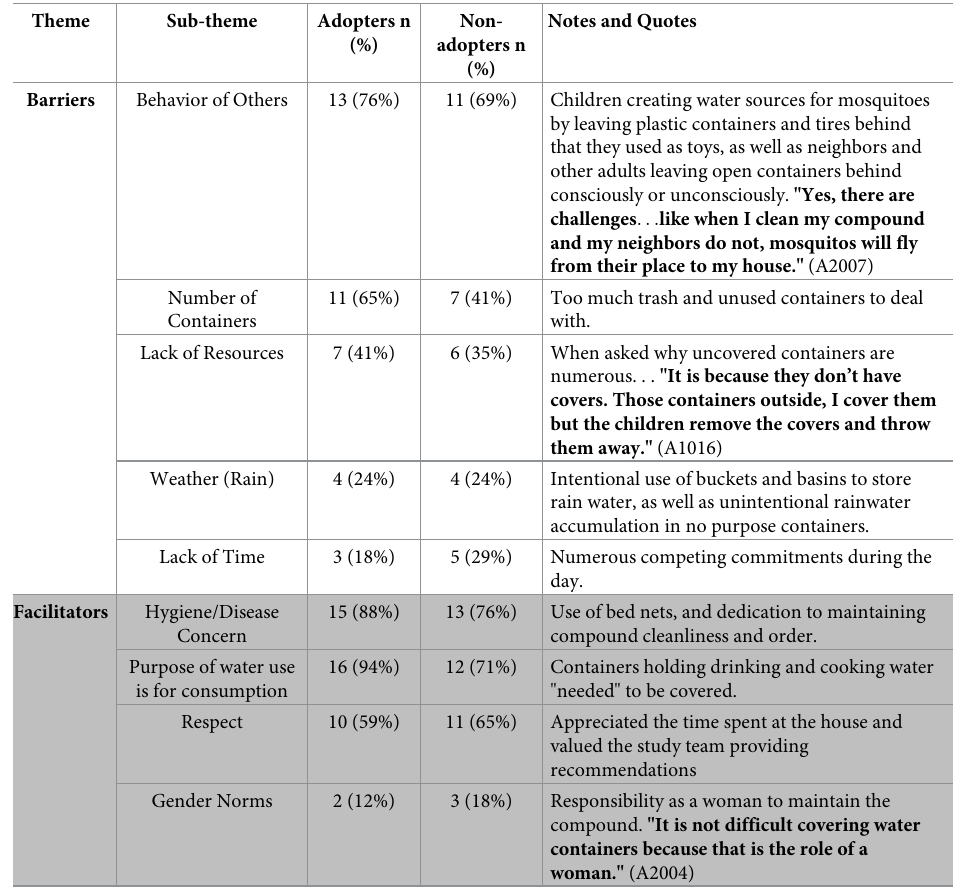
Table 4. Barriers to and facilitators of proper container management described by adopters and non-adopters during follow-up semi-structured in-depth interviews. The n and % refer to the number of respondents who men- tioned a